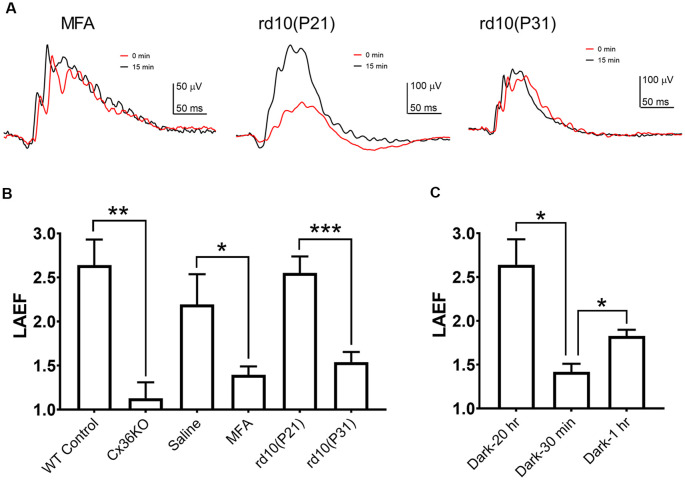
B-wave light adaptation enhancement factor (LAEF). LAEF is defined as the ratio of maximum amplitude elicited after 15 min light adaptation to the amplitude observed at the onset of the adapting light. (A) Examples of ERG waveform elicited by 100 cd.s/m2 flashes at 0 and 15 min of light adaptation for mice intravitreally injected with meclofenamic acid (MFA), rd10 at P21, and rd10 at P31. (B) LAEF obtained under each condition: control, n = 5; Cx36KO, n = 6; MFA, n = 5; P21 rd10, n = 8; P31 rd10, n = 8. (C) Effect of the dark-adaptation duration on LAEF: 20 h (same as control in A), n = 5; 30 min, n = 4; 1 h, n = 3. *p < 0.05; **p < 0.01; ***p < 0.001.